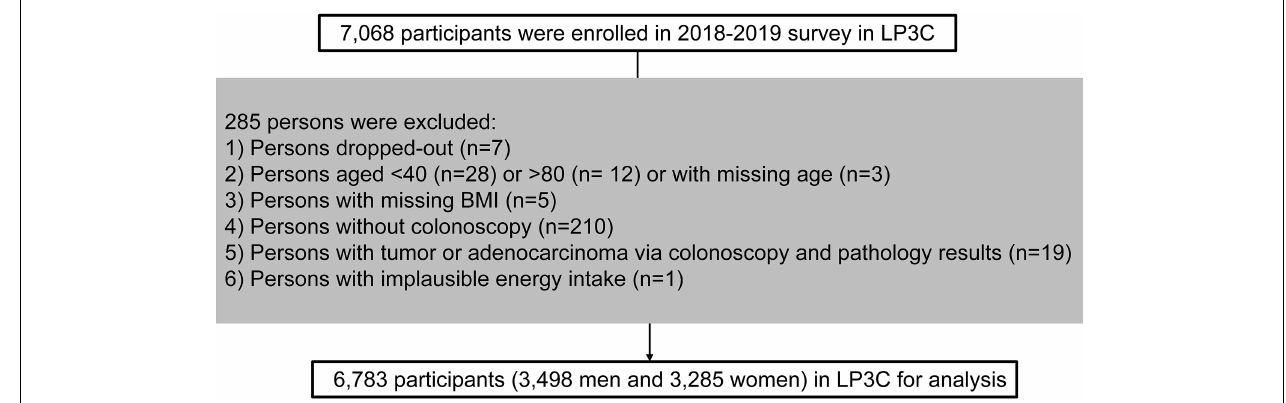
FIGURE 1 | Flow chart of study participants in the current LP3C